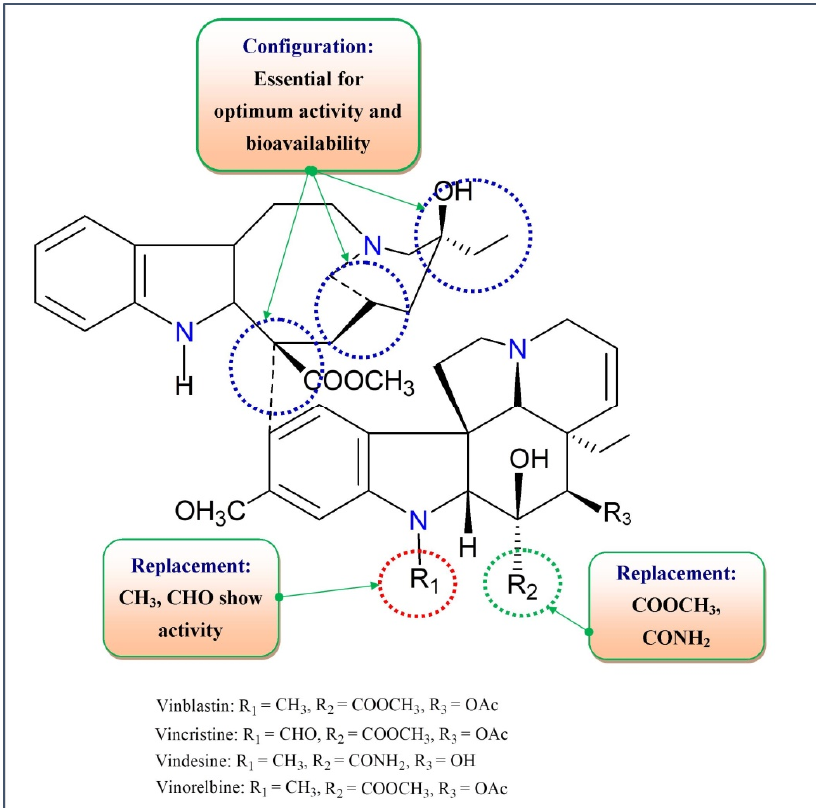
Figure 1. Overview of the SAR and analogs of VAs.